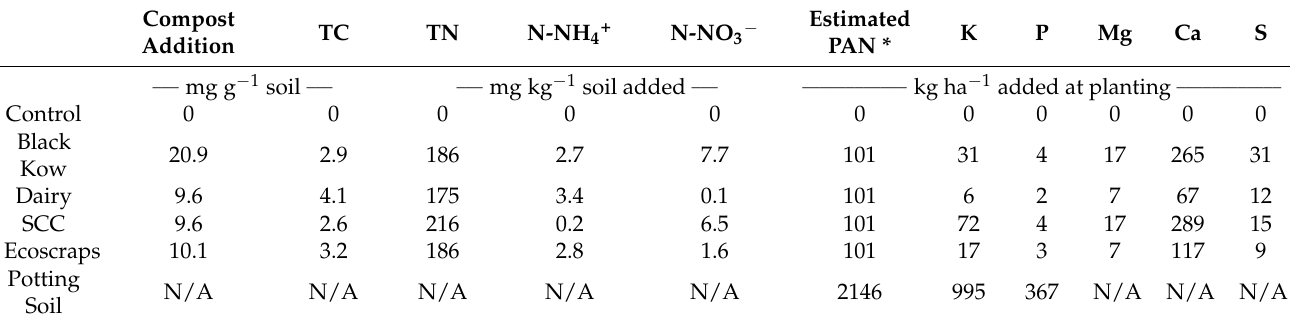
Table 4. Compost properties, application rates, and calculated nutrient